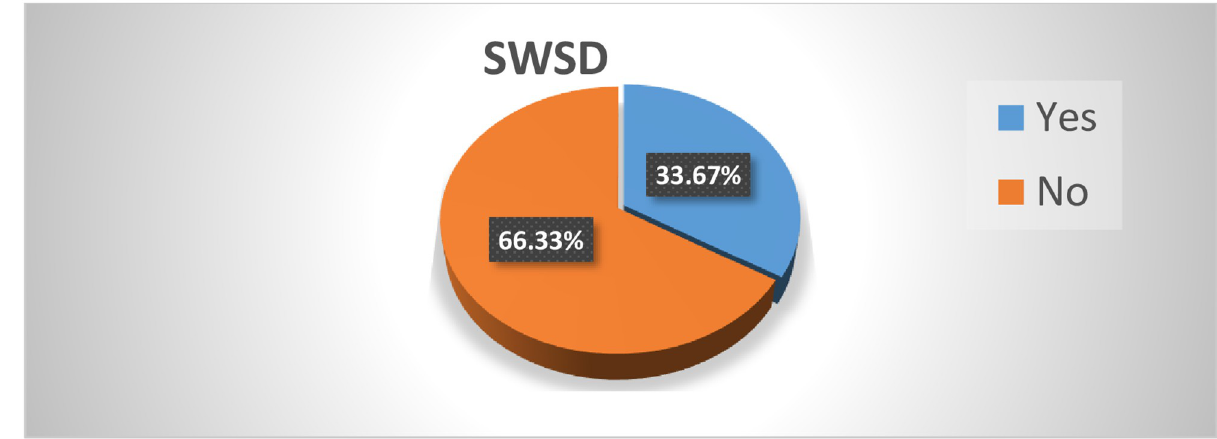
Fig 2. Shift-work sleep disorder among health care workers working at public hospitals in Sidama national regional state, Southern Ethiopia 2021 (n = 398). SWSD = Shift-work sleep disorder.